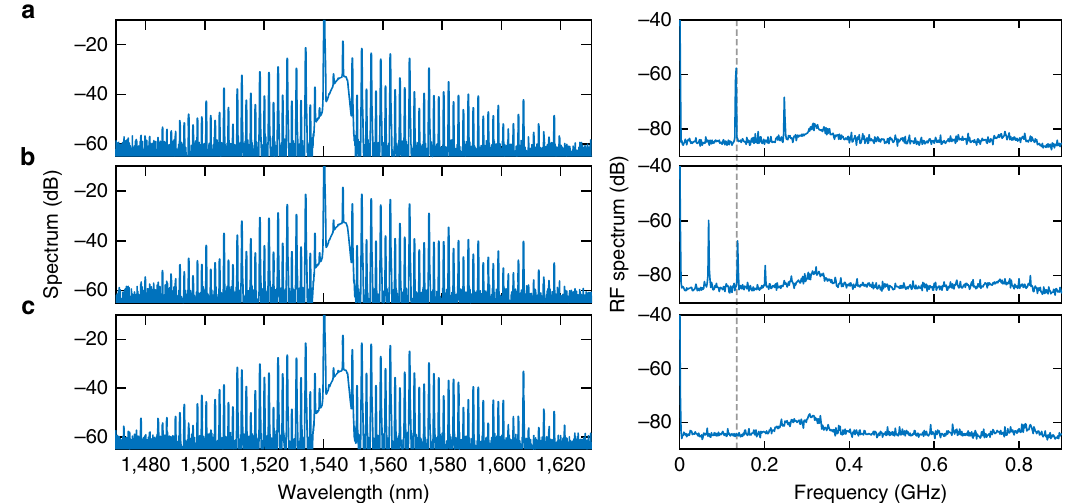
Figure 6 | Temporal cavity soliton of higher oscillatory periodicity in a Si 3 N 4 microresonator. At a higher pump power, as the pump detuning increases, the period-1 oscillation ( a ) transitions to a period-2 oscillation ( b ), and the cavity soliton finally stabilizes ( c ). The dashed line indicates that the first RF beat note in state ( a ) aligns with the second RF beat note in state ( b ) at the transition